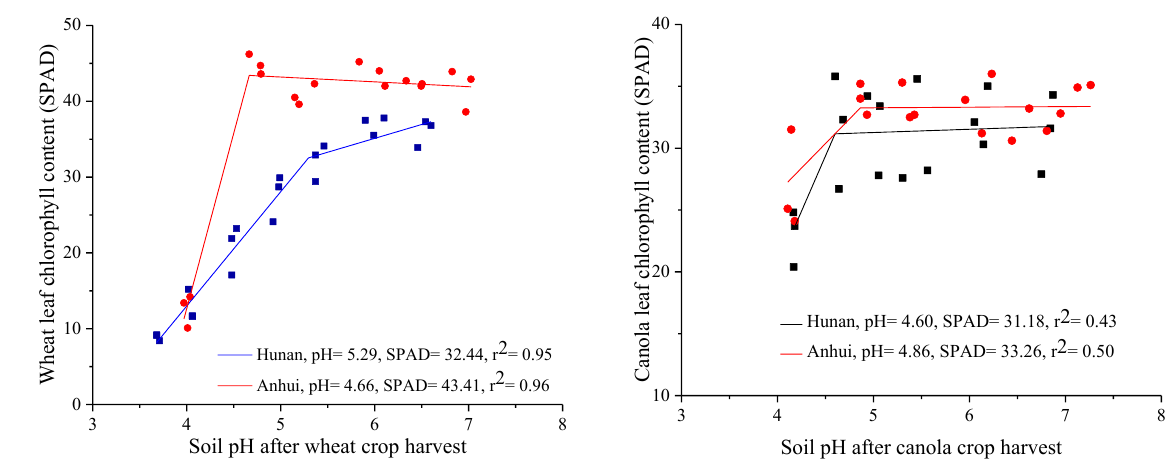
Figure 6. Leaf chlorophyll contents (SPAD value) of wheat and canola as a function of soil pH of the Ultisols from Hunan and Anhui. The fitted equations were significant at P <0.01.